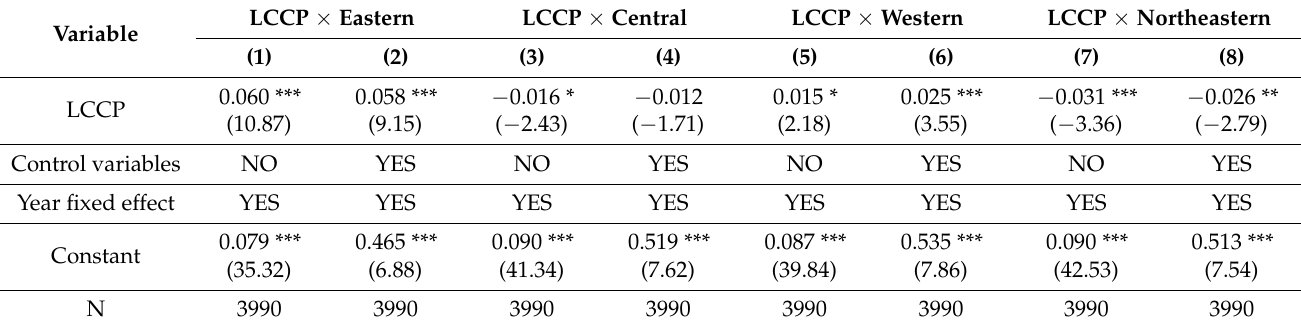
Table 5. Regional economic heterogeneity test